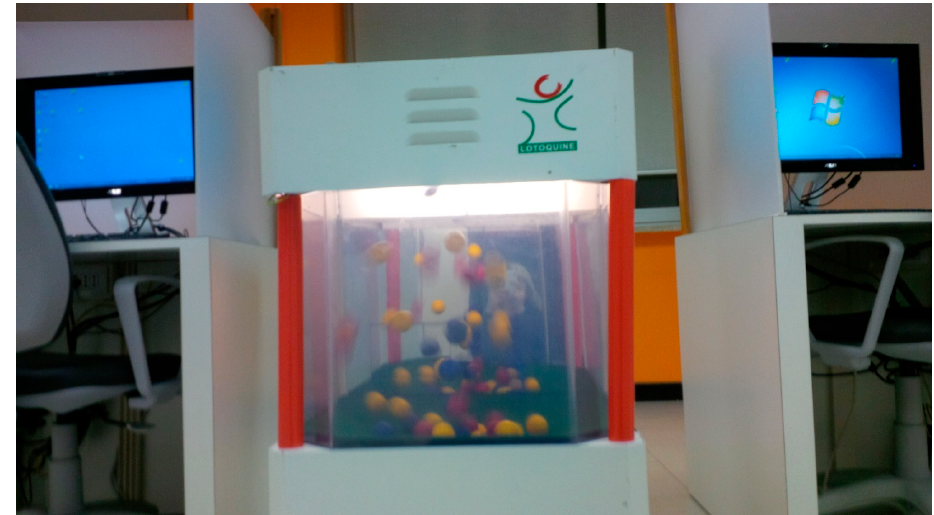
Figure A1. The Bingo Blower (photo taken in the CESARE experimental